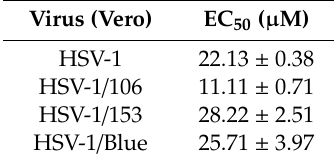
Table 2. The antiviral activity of amentoflavone on four HSV-1